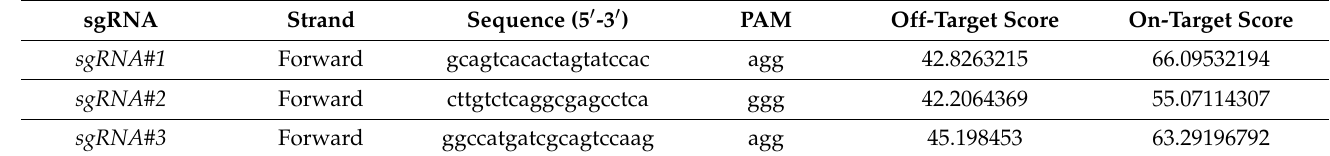
Figure 2. Generation of Cnga3 floxed-miniSTOP mice using Easi -CRISPR. ( a ) A floxed-miniSTOP cassette (393 bps) was knocked into intron 5 of the Cnga3 gene using Easi -CRISPR. The ssODN (653 bases) includes 393 bases of the floxed-miniSTOP cassette and homologous sequences at both ends (115 bases and 145 bases). Primers were designed to screen the 5 ′ and 3 ′ junction of the knock-in floxed-miniSTOP cassette. ( b , left ) In vitro digestion (IVD) assay showed the best cutting efficiency with sgRNA#3. ( b , right ) Gel image of dsDNA and ssODN, which include 393 bases of the floxed-miniSTOP cassette (393 bps) and homologous sequences at both ends corresponding to the cutting site of sgRNA#3. ( c , left ) Polymerase chain reaction (PCR) results of twelve founders using primers to screen the 5 ′ and 3 ′ junction of the miniSTOP and identified 7 mice (#2, 4, 5, 6, 9, 10, 11) of the 12 founders carry the knock-in floxed-miniSTOP cassettes. PCR was performed using primers 5 ′ F and 3 ′ R to screen for the wild-type (WT) and knock-in floxed-miniSTOP cassette allele in these 12 founders and found that only the knock-in floxed-miniSTOP cassettes allele could be amplified from founder #6. ( c , right ) PCR screening of the five F1 mice revealed four F1 mice carried the knock-in floxed-miniSTOP cassette allele. The F1 animals (#1 and #5) were intercrossed to produce homozygous F2 offspring to confirm penetrance. ( d , right ) PCR screening using primers 5 ′ F and 3 ′ R on six F2 mice showed two WT, two heterozygous, and two homozygous of Cnga3 floxed-miniSTOP mice. ( d , bottom ) Direct sequence from #3 F2 mice showed successfully knock-in floxed-miniSTOP cassette in the intron 5 of the Cnga3 gene. Table 1. Sequence of